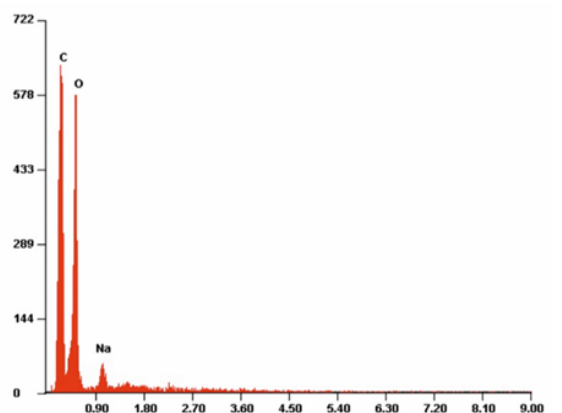
Figure 7. Example of the energy-dispersive X-ray spectroscopy (EDS) spectrum of PLA nonwoven fabric.